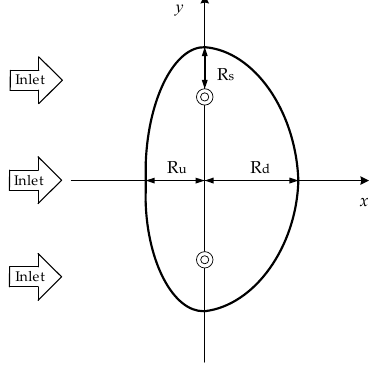
Figure 14. The positions ofR u , R d ,R S .